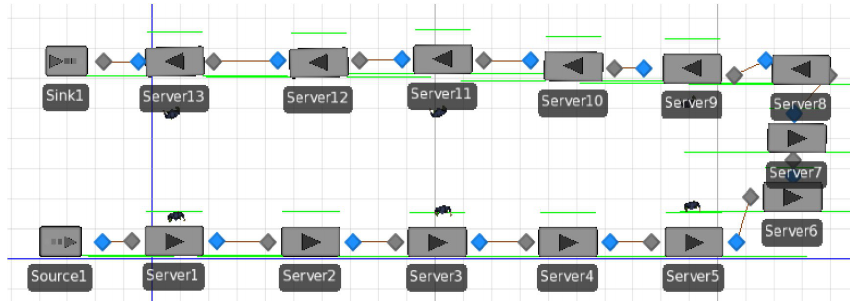
Figure 5. The basic model under SIMIO